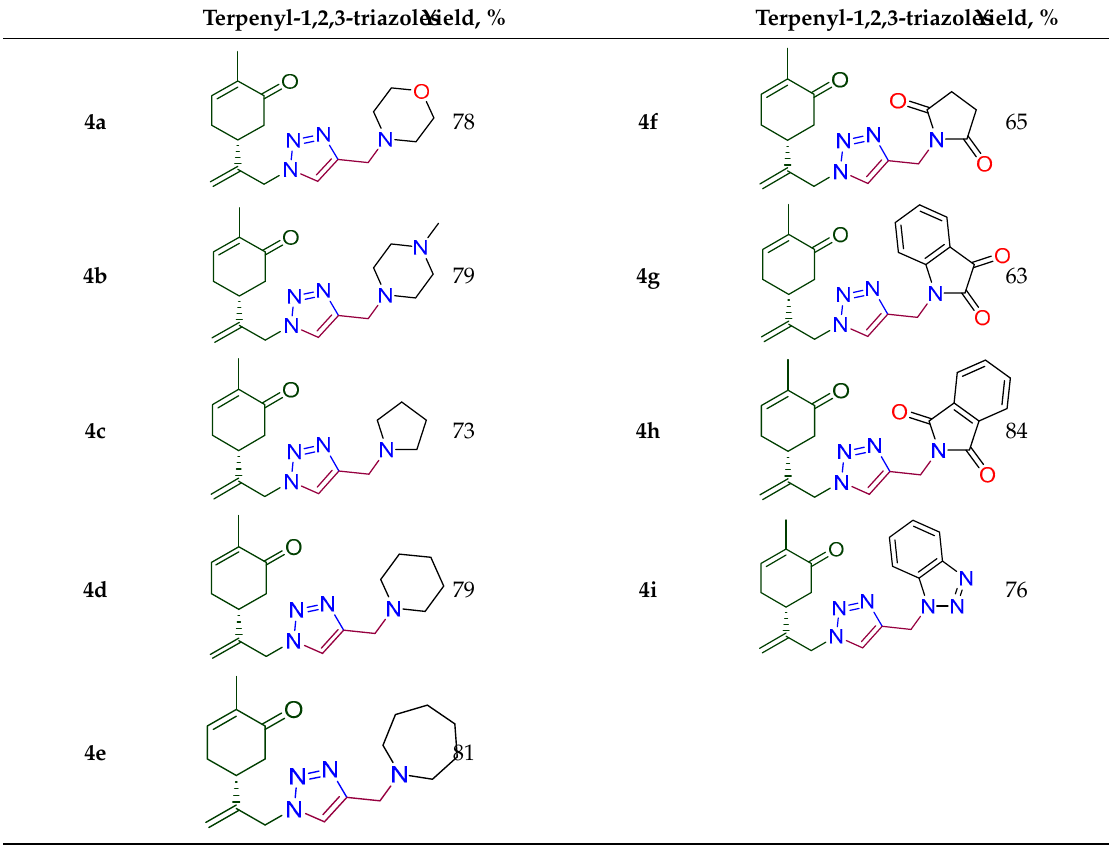
Table 2. Synthesis of terpenyl-1,2,3-triazoles 4a – i . Terpenyl-1,2,3-triazoles Yield, %